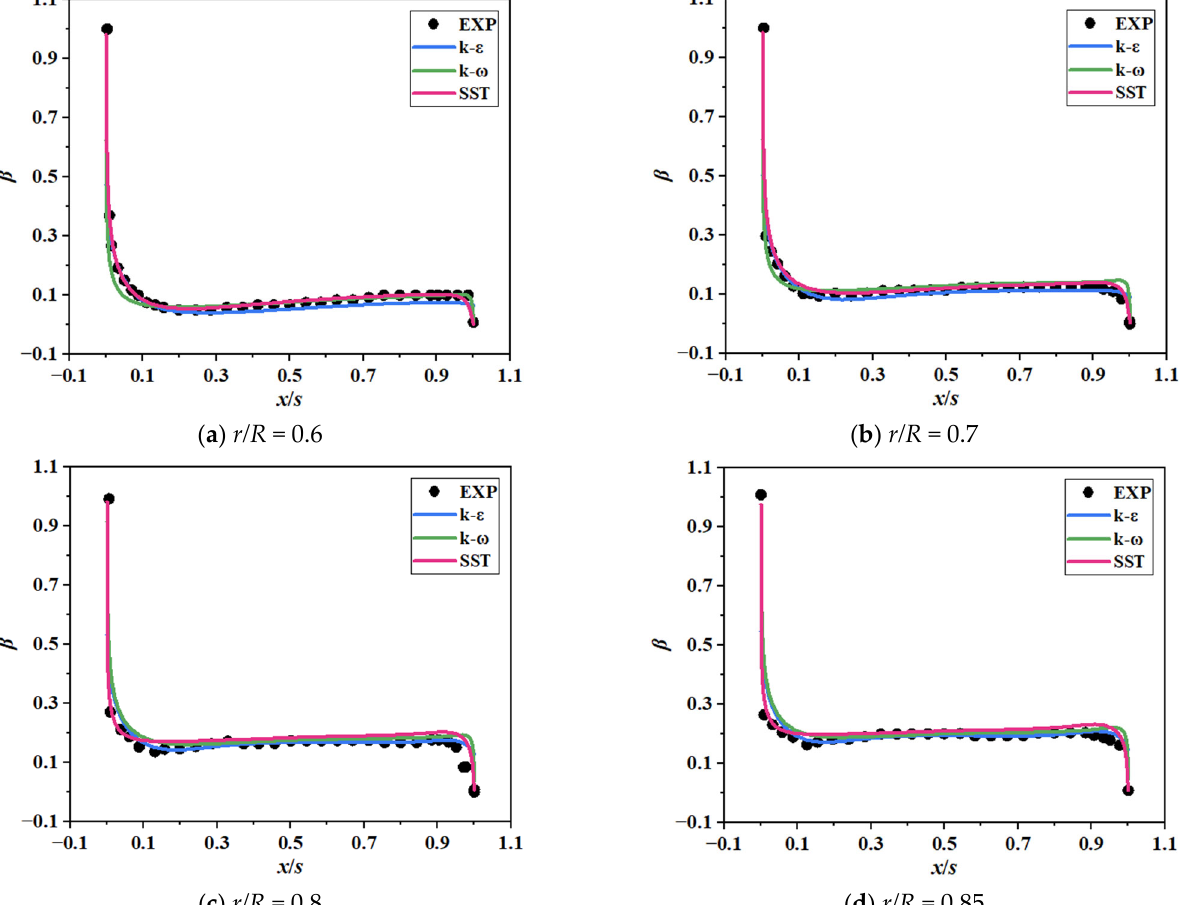
Figure 9. Swirl ratio distribution ( C w = 6100).